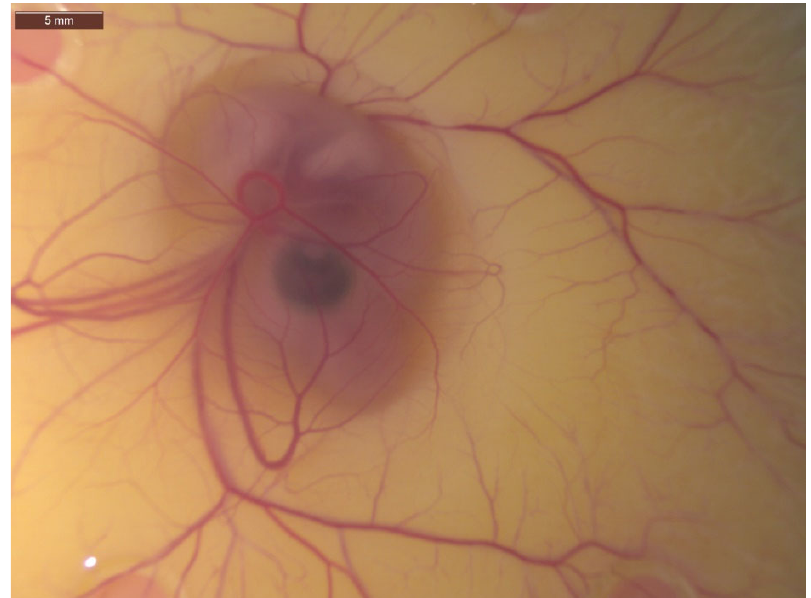
Figure 1. Image of 7-day-old chick embryo with associated chick chorioallantoic membrane (CAM) and its vast vascular network of capillaries, veins and arteries visible. Image taken at 25× magnification.